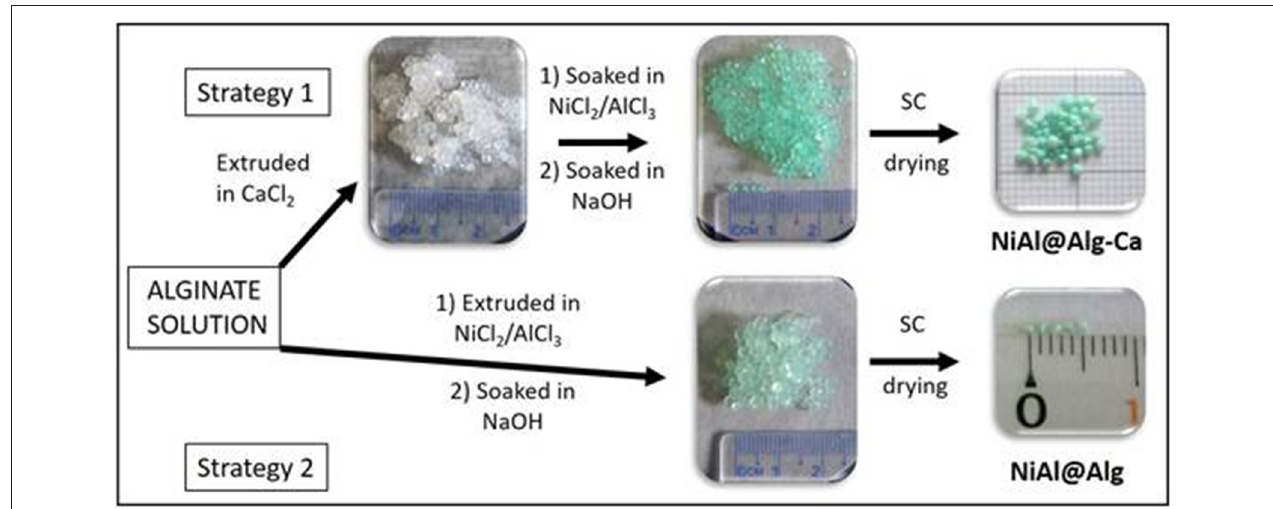
FIGURE 1 | Scheme of preparation of NiAl nanoparticles confined in Alg beads using either Ca-Alg as a template for confined LDH coprecipitation (Strategy 1) or alginate cross-link by NiCl 2 and AlCl 3 metal salt solution (Strategy 2). For both strategies, the LDH coprecipitation was induced by soaking in a NaOH (1M) solution and bionanocomposite beads were dried in CO 2 supercritical